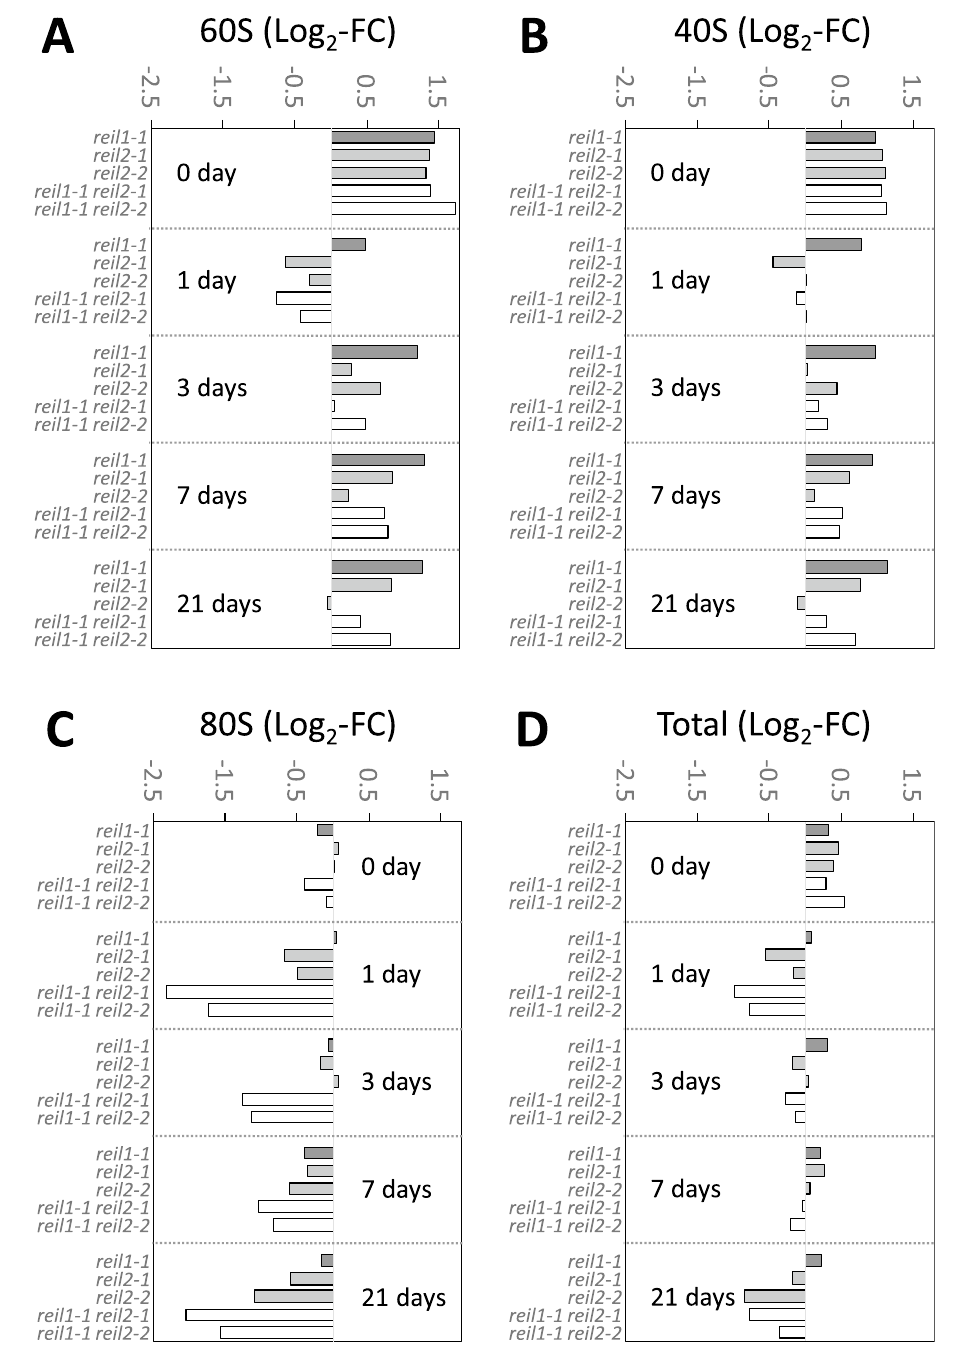
Figure 2. Relative quantification of abundances of ribosome complexes from non-acclimated (0 day) and 10 °C cold acclimating reil mutants at 1, 3, 7, or 21 days after shift (cf. Figure 1). Baseline corrected peak areas of ribosome complexes were integrated and log 2 -transformed ratios calculated relative to the wild type fractions at each time point, i.e. Log 2 -fold change (FC). The 60S LSU ( A ), 40S SSU ( B ), 80S monosomes ( C ) and the sum (“total”) of all detected ribosome complexes ( D ), were analyzed (dark grey : reil1-1 , light grey: reil2-1 and reil2-2 , white: double mutants, reil1-1 reil2-1 and reil1-1 reil2-2